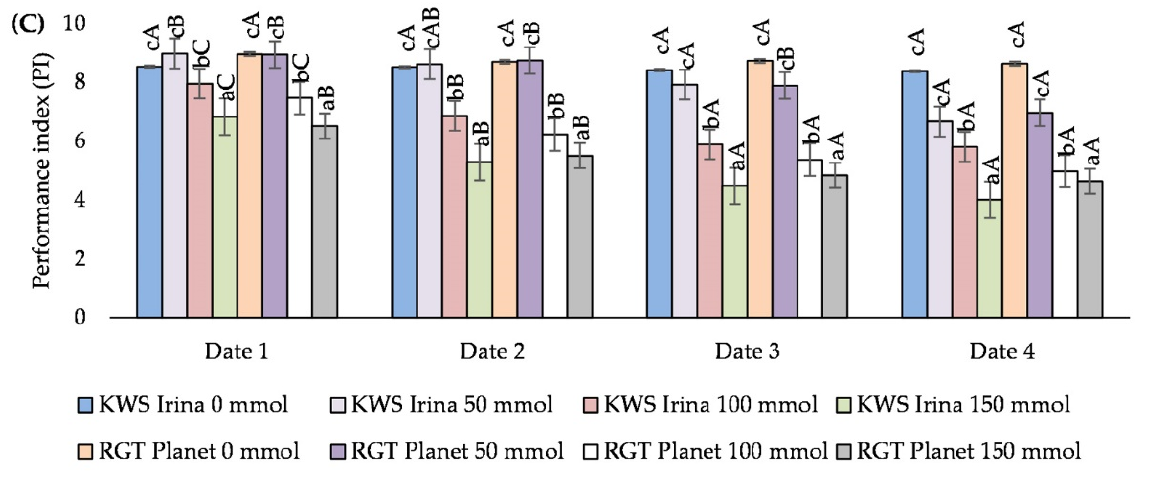
Figure 2. The effect of NaCl (mmol NaCl (dm 3 ) − 1 ) concentration and measurement date on chlorophyll fluorescence parameters: maximal quantum yield of PSII photochemistry (F v /F m ) ( A ), maximum primary photochemistry yield (F v /F 0 ) ( B ), and PS II performance index (PI) ( C ) in the varieties of KWS Irina and RGT Planet (date 1, 7 days after NaCl application; date 2, 14 days after NaCl application; date 3, 21 days after NaCl application; date 4, 28 days after NaCl application) * Capital letters indicate significant differences between the means in the measurement dates for particular NaCl concentrations, and lower case letters indicate significant differences between the means at subsequent measurement dates ( p = 0.05).